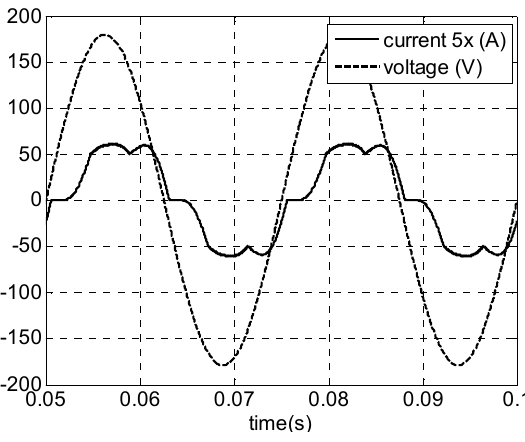
Figure 2. Generator’s voltage and current.